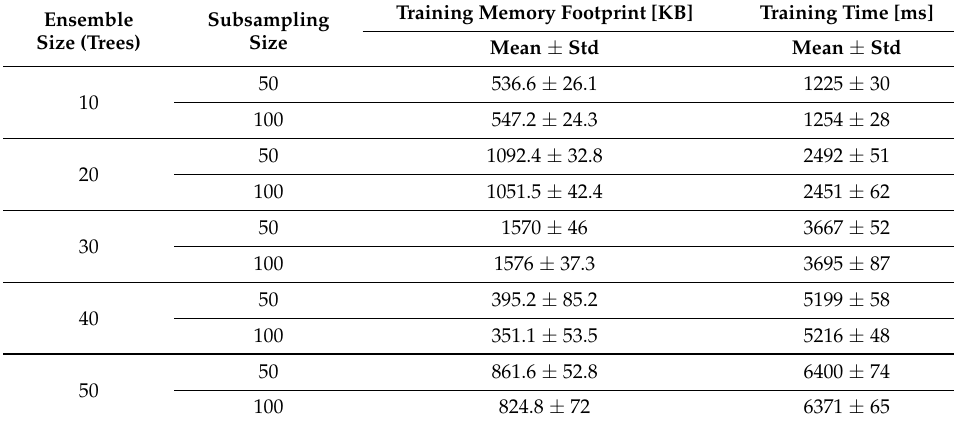
Table 4. IoT Kit system metrics during the Training Mode.